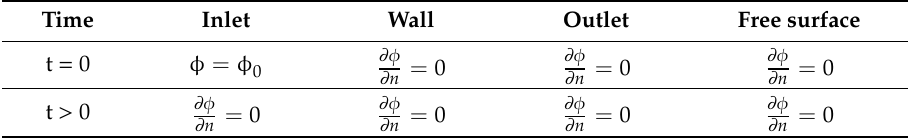
Table 3. Initial and boundary condition for tracer